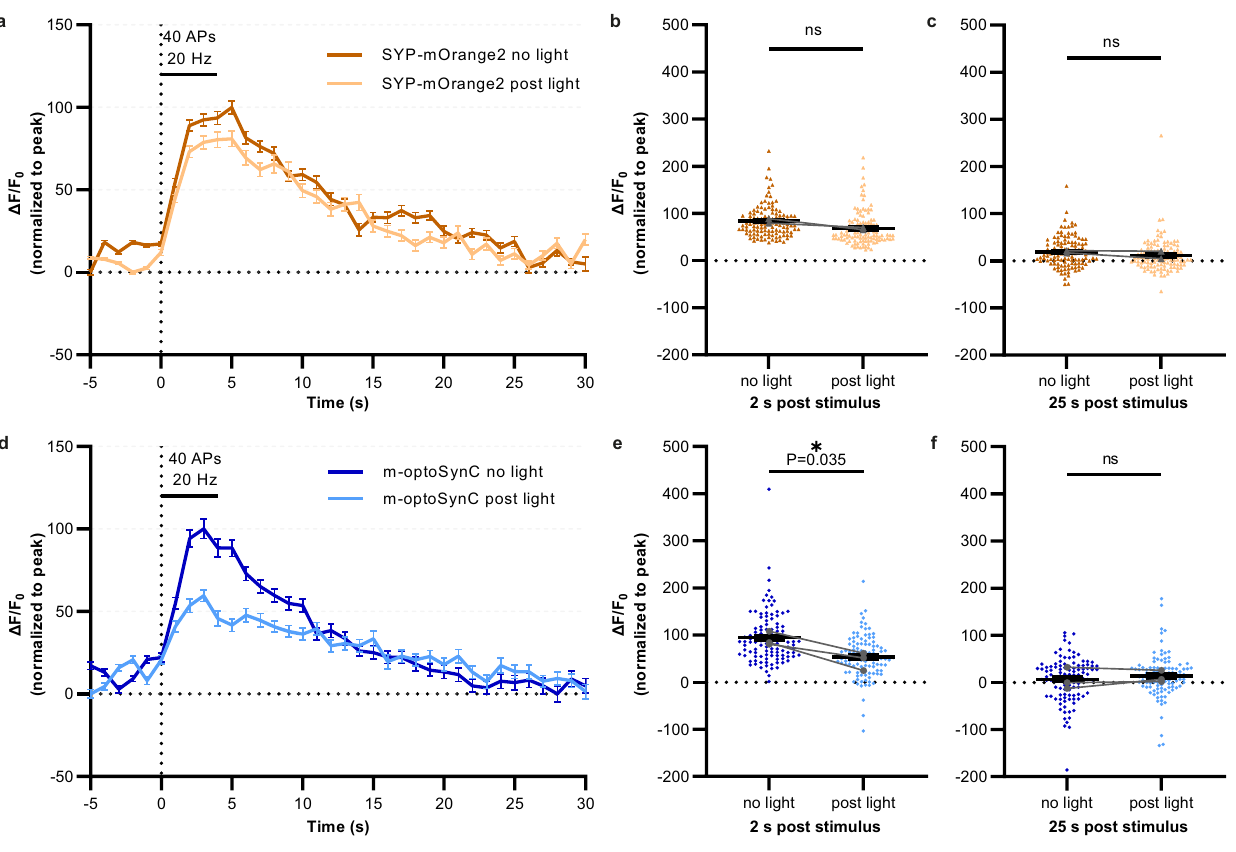
Fig.6|m-optoSynCactivationinmurinehippocampalneuronsblockssynaptic transmission. a Plot showing changes in normalized fl uorescence intensity of mOrange2 by electrical fi eld stimulation of neurons expressing mOrange2-SYP before (black line) and after 488nm illumination for 30s (green line). N =2 independentcultures. n =5neuronsand116synapses. b , c Normalized fl uorescence